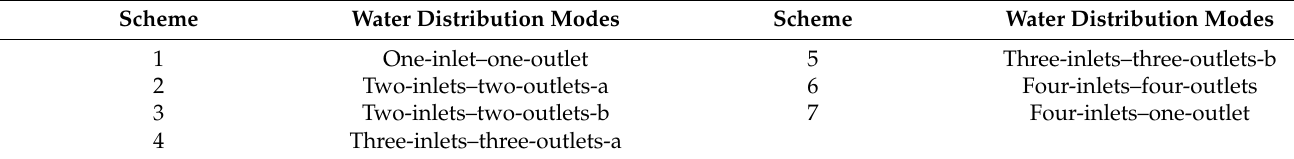
Table 10. Water Distribution Schemes for the Reservoir.